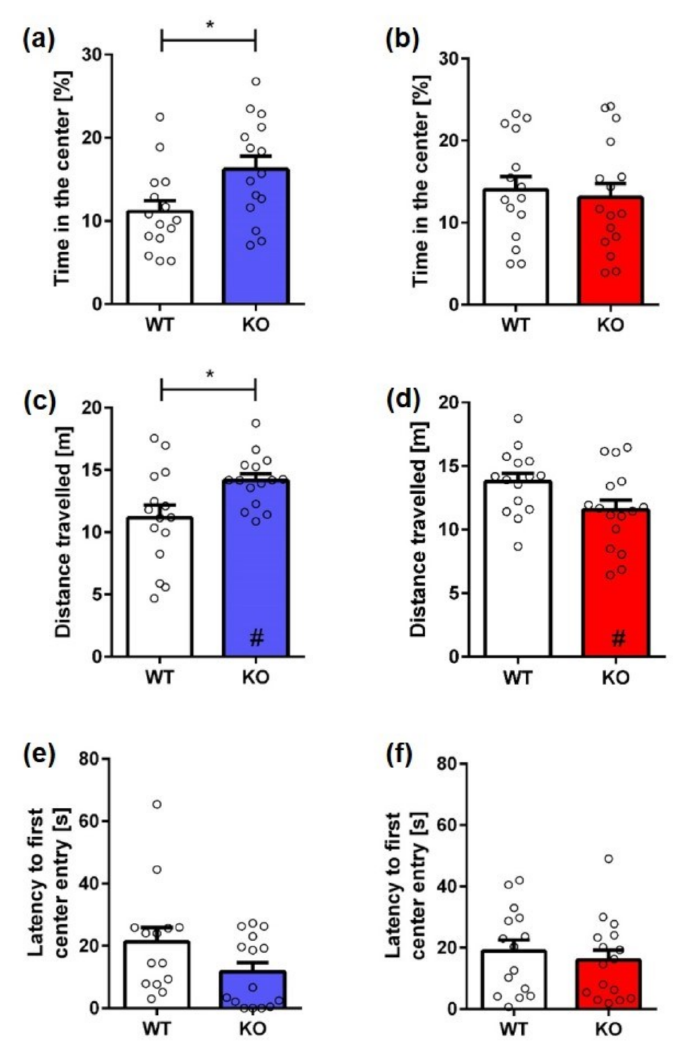
Figure 5. Exploration and anxiety behavior of Mover KO mice in the open field. Male KO mice spent more time in the center of the arena ( a ) and were more active than WT animals ( c ). In contrast, there was no significant difference in the time spent in the center of the box ( b ) or the distance traveled ( d ) between female KO and WT animals. The latency to first enter the center of the arena did not differ between KO and WT mice, independent of sex ( e , f ). Unpaired t -test, n = 15–17. Data presented as mean ± S.E.M. * p < 0.05 (genotype difference); # p < 0.05 (sex